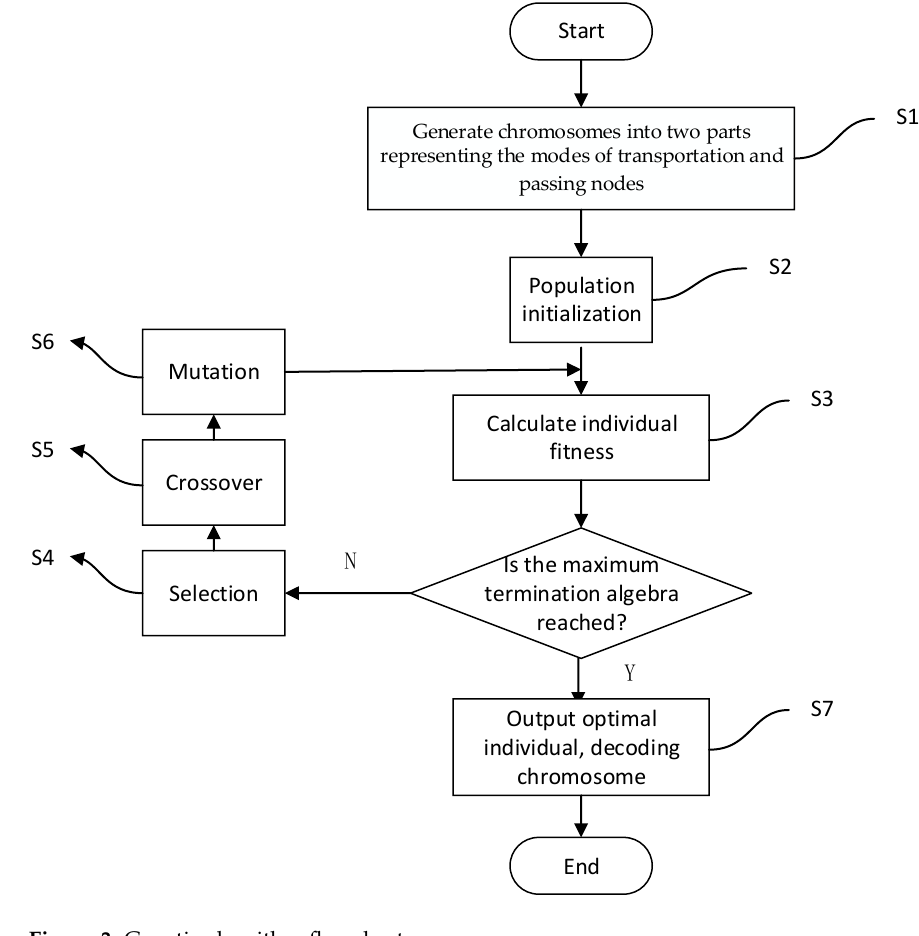
Figure 3. Genetic algorithm flowchart.